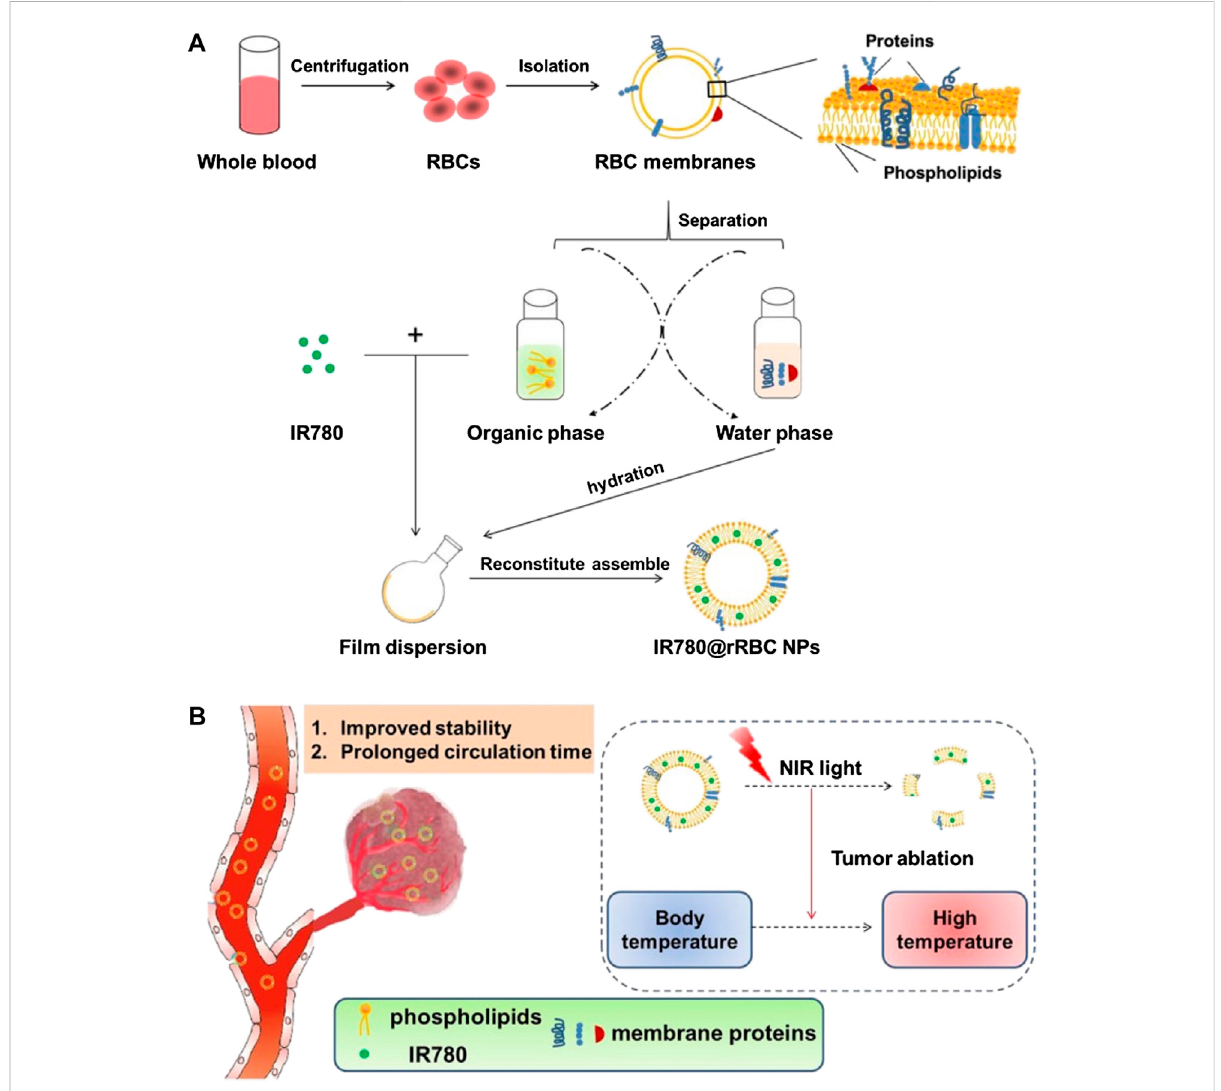
FIGURE 3 SchematicillustrationofproceduresforthepreparationofIR780loadedreconstituteRBCmembranenanoparticles(IR780@rRBCNPs) (A) RBC membrane was prepared by a hypotonic lysis method. Then RBC membranes were treated by mixed organic solvent, to separate the lipids and proteins. Lipid part was used to load IR780 by fi lm dispersion method. At last, IR780@rRBC NPs were formed by adding proteins with the fi lm, following further extrusion (B) IR780@rRBC NPs increased stability in vitro , and prolonged circulation capacity and enhanced PTT ef fi cacy in vivo